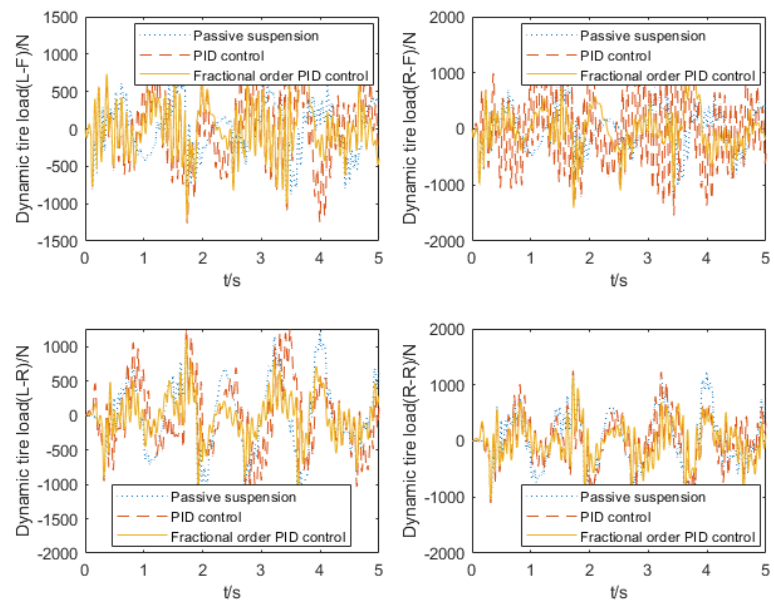
Figure 19. Dynamic tire load simulation results.